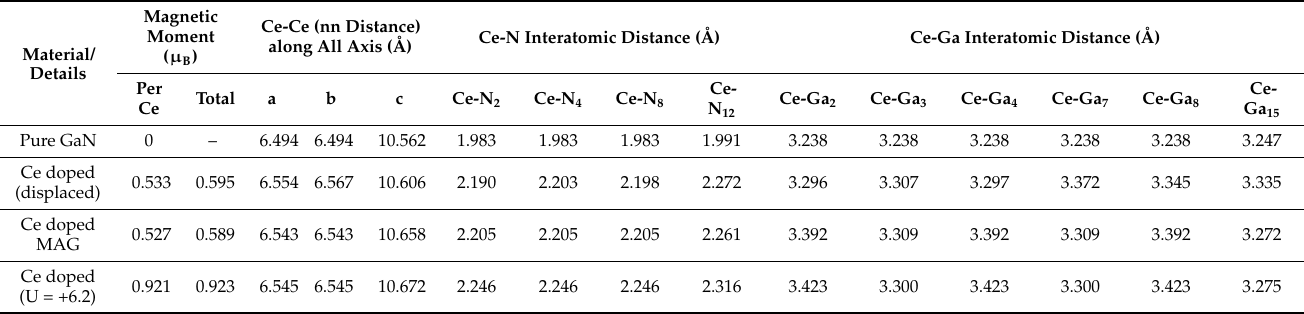
Table 4. The values of magnetic moment, and structural parameters computed for pure GaN and Ce:GaN without and with Hubbard